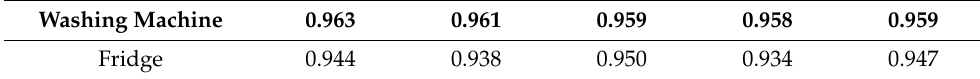
Figure 9. Disaggregation output of the swimming pool pump. Blue, ground truth active power; red, predictive active power; yellow, aggregate active power. Table 7. F1 score using cross validation.